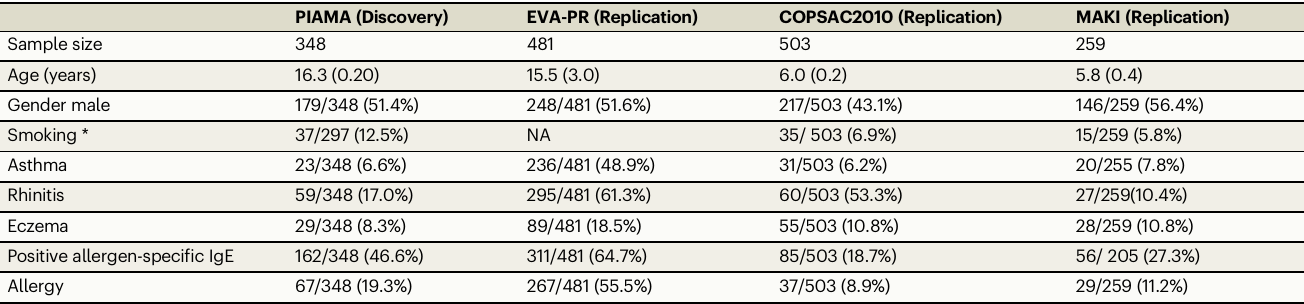
Fig. 1 | Study design to develop and validate the prediction model and func- tionally interpret its predictors. a We integrated multi-omics data, including, genetics, DNA methylation from blood and nasal brushes, and environmental fac- tors from the PIAMA cohort. Using machine learning methods, we aimed to (1) assess the contribution of each data layer to the performance of a prediction model;and(2)presentasimplepredictionmodelforallergicdisease. b Todevelop a parsimonious prediction model,we fi rst ranked all features from the full dataset, then features were added incrementally until no signi fi cant increase in perfor-